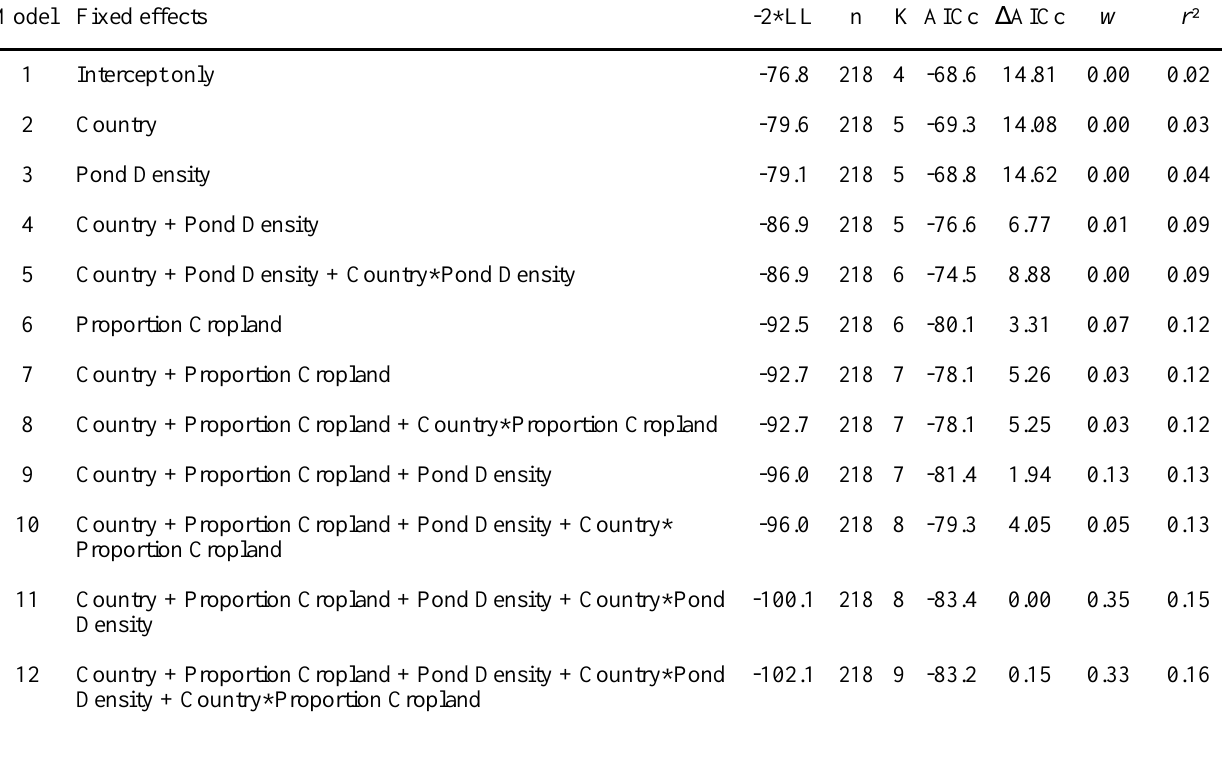
Table 2 . Ranking of 12 general mixed linear models relating the nest success of dabbling ducks as a function of country (Canada vs. United States), proportion cropland, pond density, and their interactions in North American prairies between 1964 and 1995. Each model had year and study site nested in survey strata as random effects. n = sample size; K = number of parameters; AICc = Akaike’s Information Criterion, corrected for small sample sizes; D AICc = the difference in AICc between each model and the model with the minimum AICc; w = Akaike weight, and r ² = the proportion of the total variation in nest success explained by each model (Xu